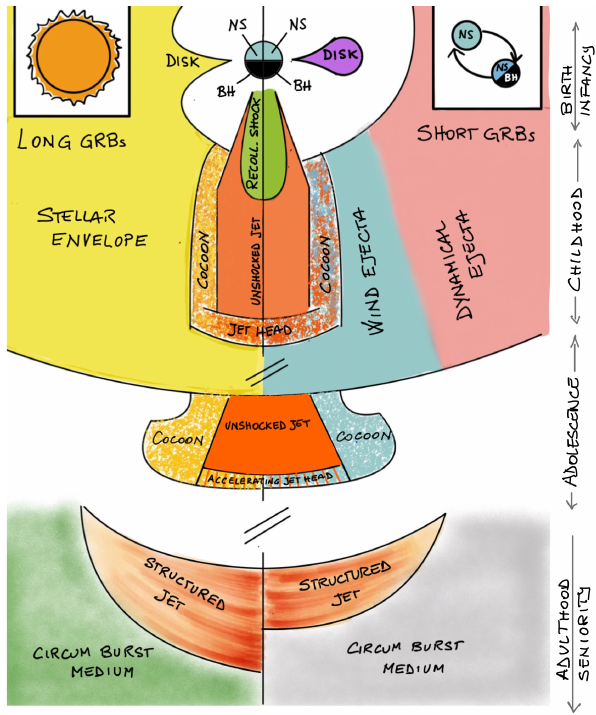
Figure 2. Artist’s impression of the different phases in the early evolution of a GRB jet (long and short GRBs schematically represented on the left-hand and right-hand side, respectively). The putative progenitors are depicted in the stamps on the top corners. The formation of a compact central object (BH or NS) accompanied by an accretion disk powers a relativistic jet, determining the properties at its base (“birth”). The jet expands within the progenitor vestige (stellar envelope—left—or merger ejecta and disk winds—right) and starts interacting with it (“infancy”). The cocoon formed by ambient and jet-shocked material produces an inward pressure that collimates the jet as it propagates (”childhood”). As the jet breaks out (“adolescence”) its head accelerates and the cocoon blows out. The subsequent phases (“adulthood and seniority”, described in the text) are responsible for the prompt and afterglow emissions. See Section 2.2 for the description of the phases through which a jet